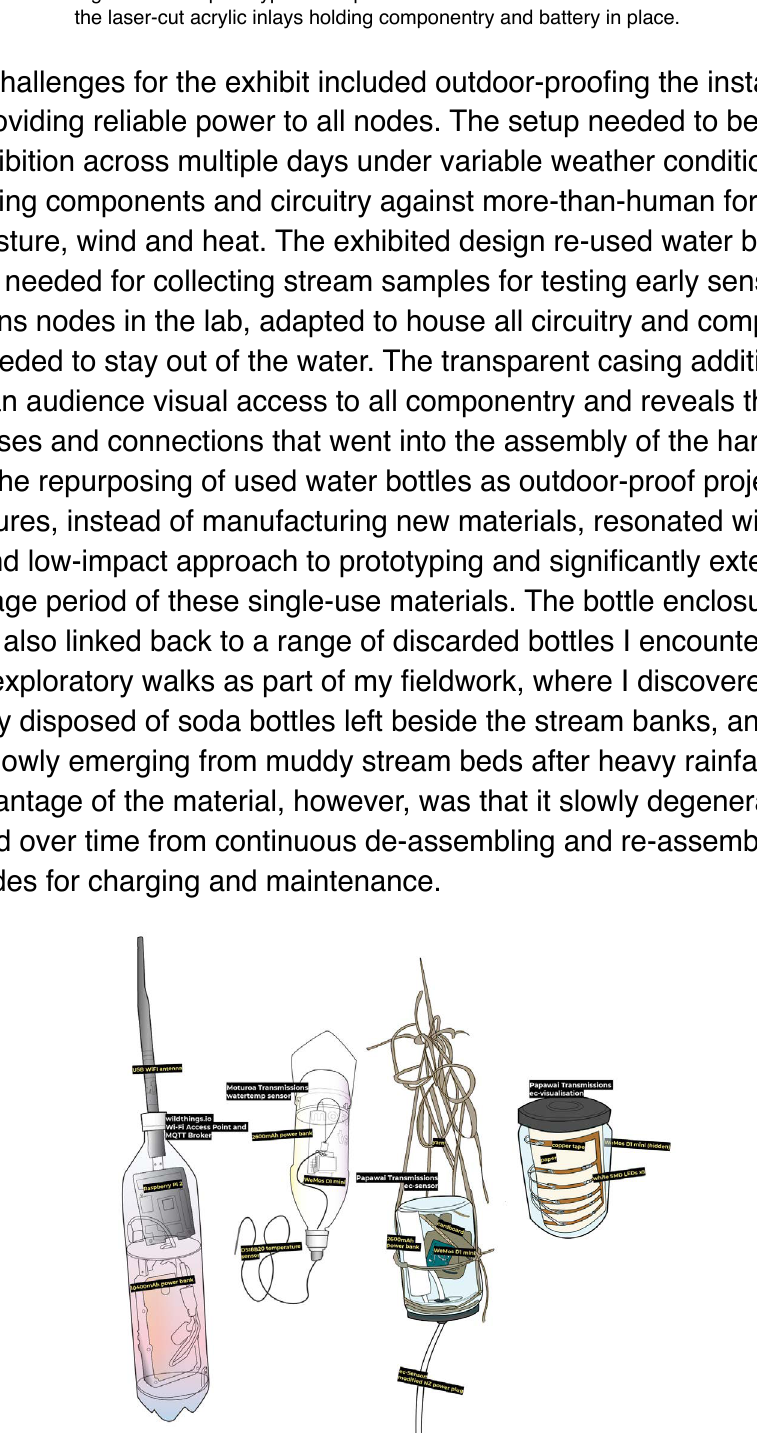
Figure 5: Iterations of networked prototypes showing the Wi-Fi hub and MQTT broker (1), the design of the Moturoa Transmissions water temperature sensor (2), and the Papawai Transmission ec-sensor(3) and ec-visualisation (4)